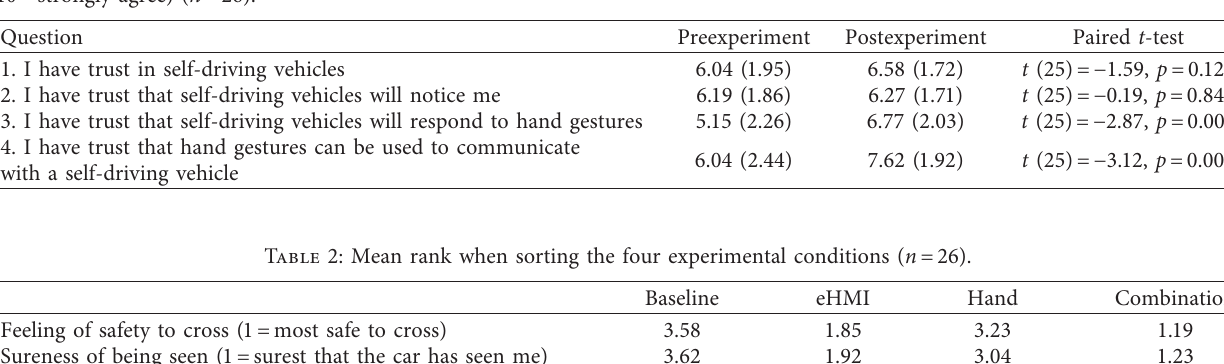
Table 1: Responses to pre- and postexperiment questions regarding trust in automated vehicles and hand gestures (1 � strongly disagree and 10 � strongly agree) ( n � 26).